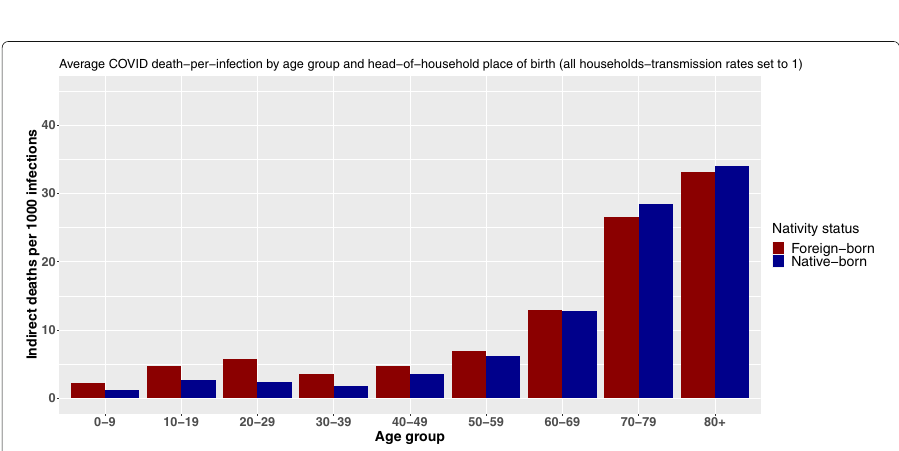
Fig. 13 Average COVID-19 deaths per 1000 infections by age group and head-of-household nativity status (rates of transmission set to 1)